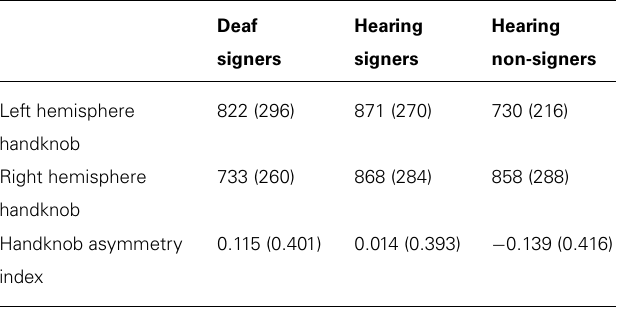
Table 4 | Motor handknob cortical volumes and asymmetry